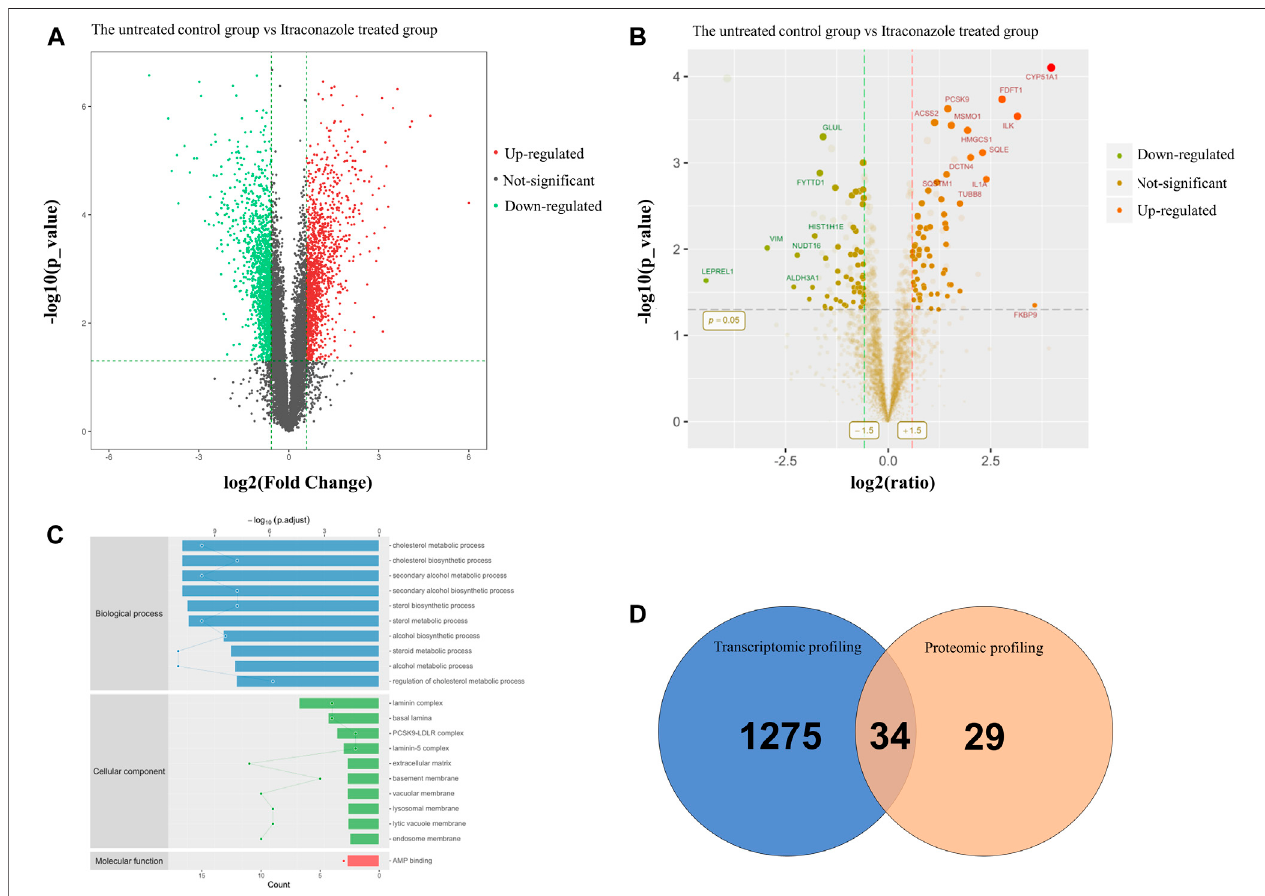
FIGURE 3 | Transcriptomic and proteomic pro fi ling of A431 cells treated with itraconazole. (A) Volcano plot of RNA-seq data. The horizontal line represents a p -value of .01, whereas the vertical lines correspond to 1.5-fold increase and decrease. (B) Volcano plot of iTRAQ data. The horizontal line represents a p -value of .05, whereas the vertical lines correspond to 1.5-fold increase and decrease. (C) GO enrichment analysis of BP, CC and MF. (D) The intersection of transcriptomic and proteomic pro fi ling datasets showed overlap of 34 upregulated proteins in A431 cells.